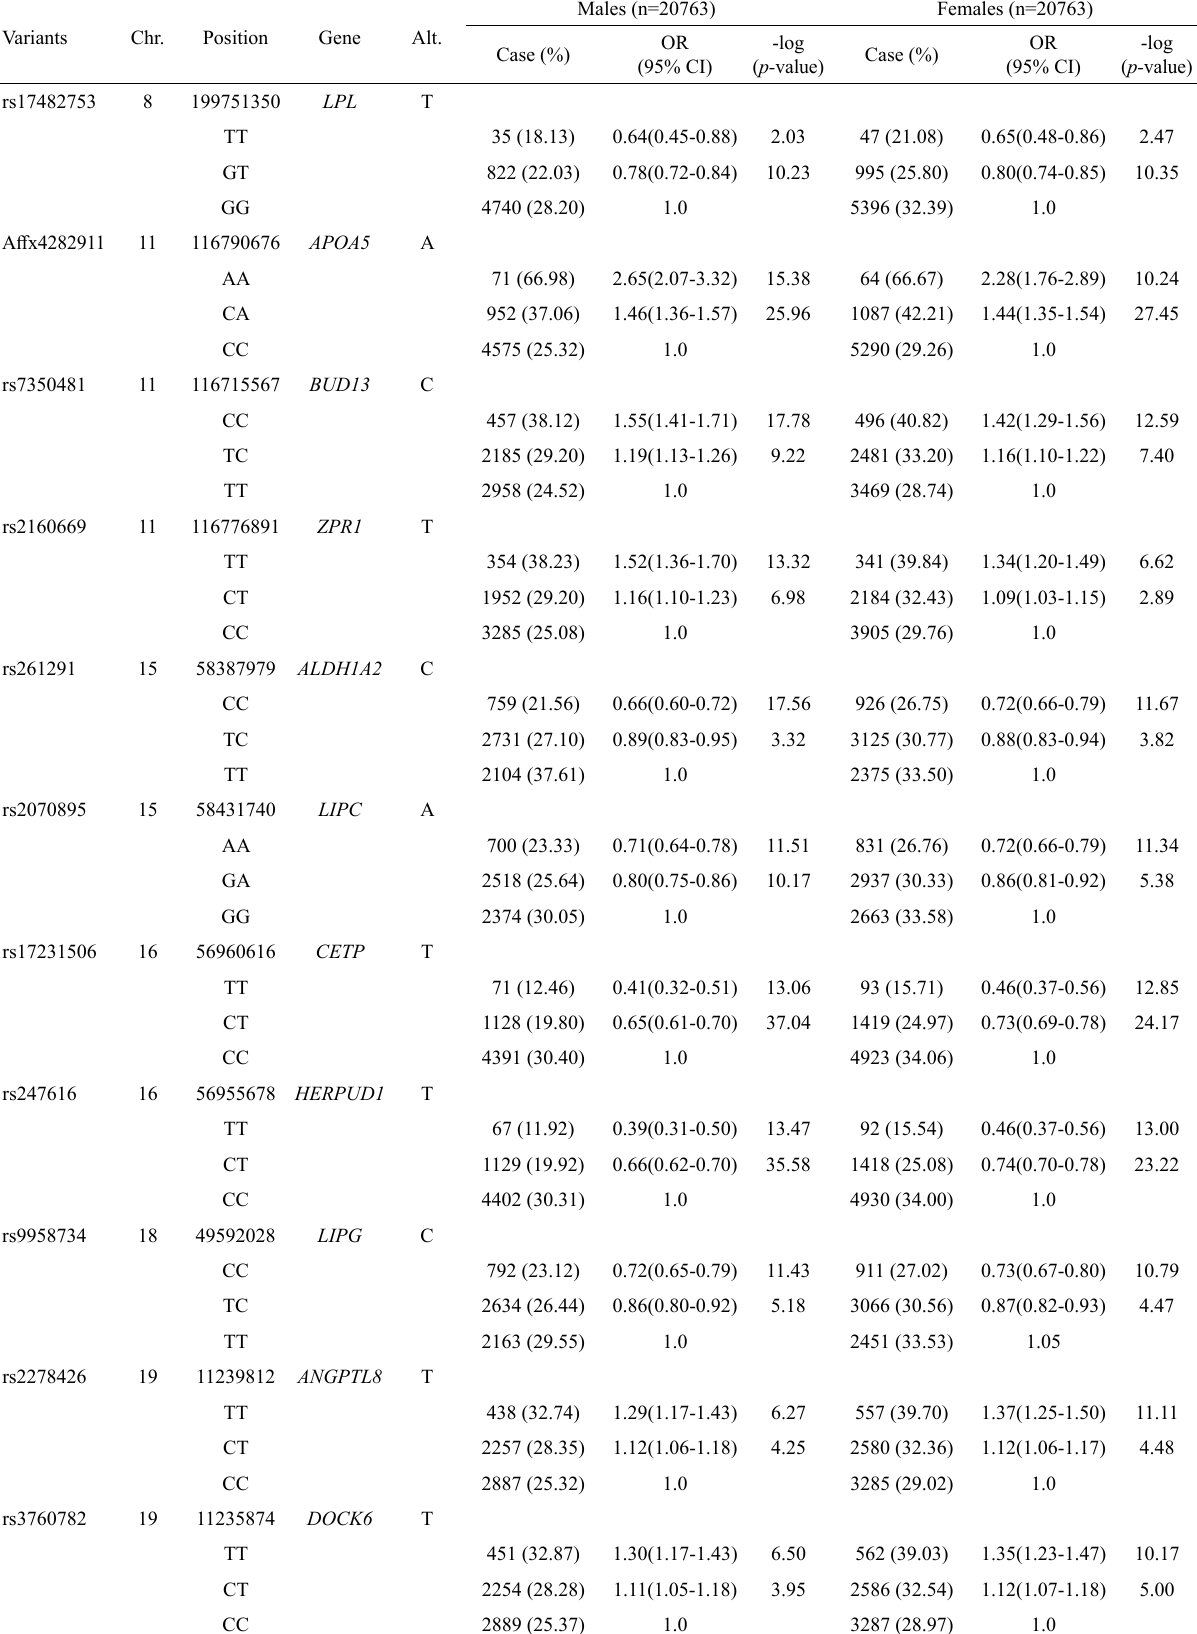
Table 4 – The ORs and allele information of polymorphisms which were significantly related to low-HDL-C in both males and females.